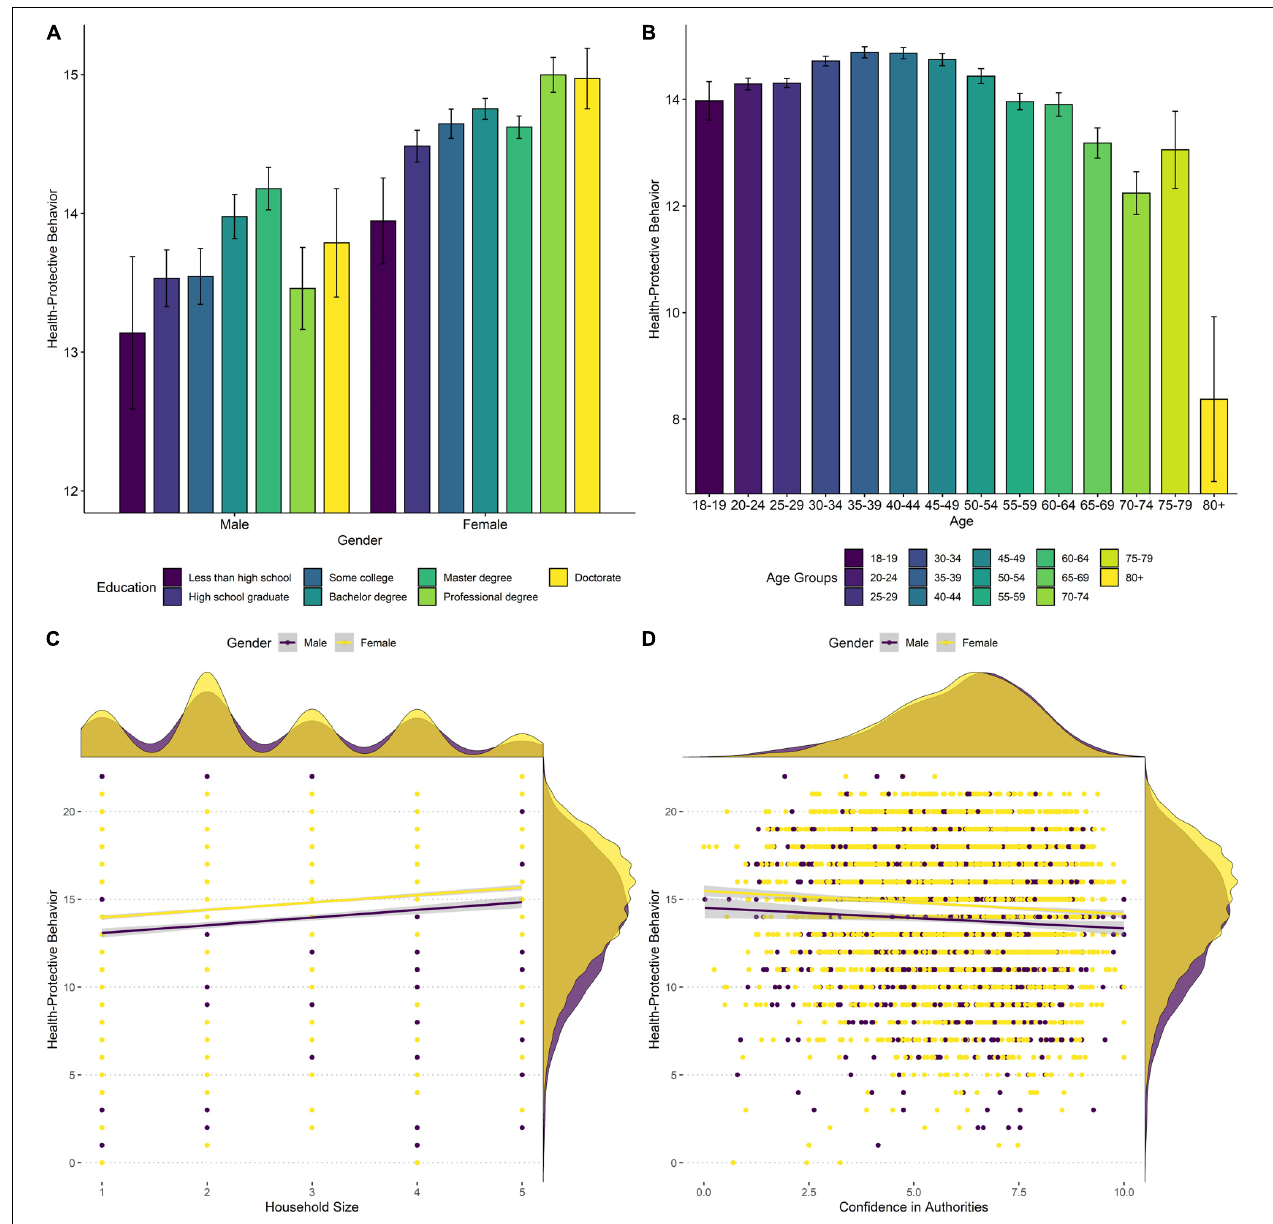
FIGURE 3 | (A) Health-protective behavior by gender and education level. (B) Health-protective behavior by age group. (C) Association of health-protective behavior and household size separately for gender. (D) Association between health-protective behavior and confidence in authorities separately for gender.